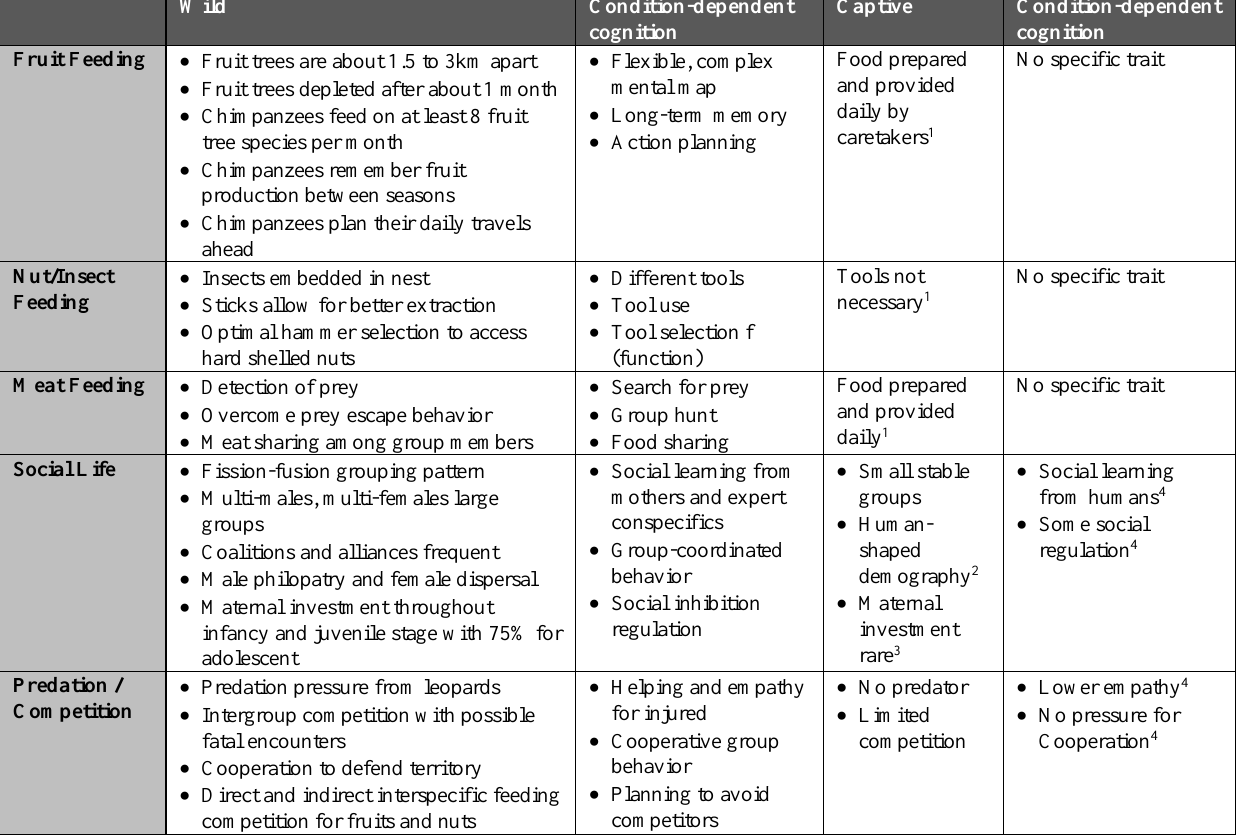
Cognitive Ecology of Chimpanzees Compared Between Wild and Captive Living